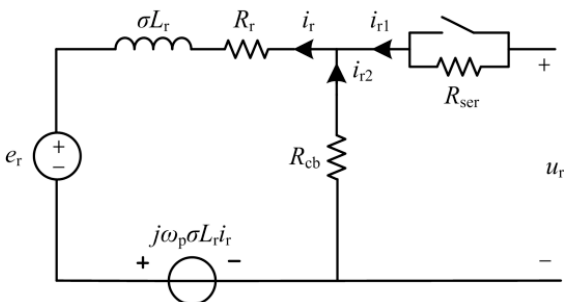
Figure 7. Rotor equivalent circuit of the DFIG.